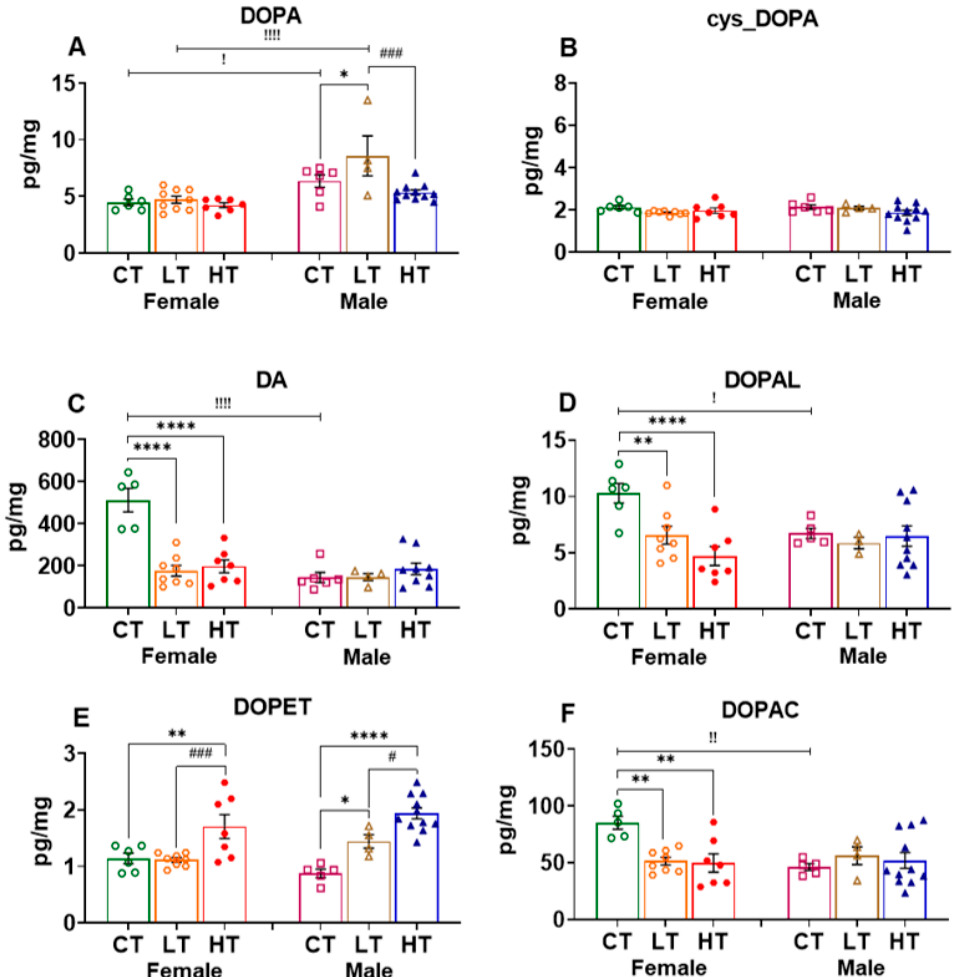
Figure 2. Levels of dopamine and its metabolites in the prefrontal cortex (PFC). ( A ) DOPA, ( B ) cys_DOPA, ( C ) DA, ( D ) DOPAL, ( E ) DOPET, and ( F ) DOPAC in female and male METH rats compared to controls after 30 days of withdrawal from METH SA. Key to statistics: * p < 0.05, ** p < 0.01, **** p < 0.0001, comparison between controls vs. low and high METH-taker groups; # p < 0.05, ### p < 0.001, comparison between low and high METH-taker groups; ! p < 0.05, !! p < 0.01, !!!! p < 0.0001, comparison between female and male rats. All values represent means ± SEM of number of animals indicated in the figure. CT, control saline rats; LT, low METH takers; HT, high METH takers.